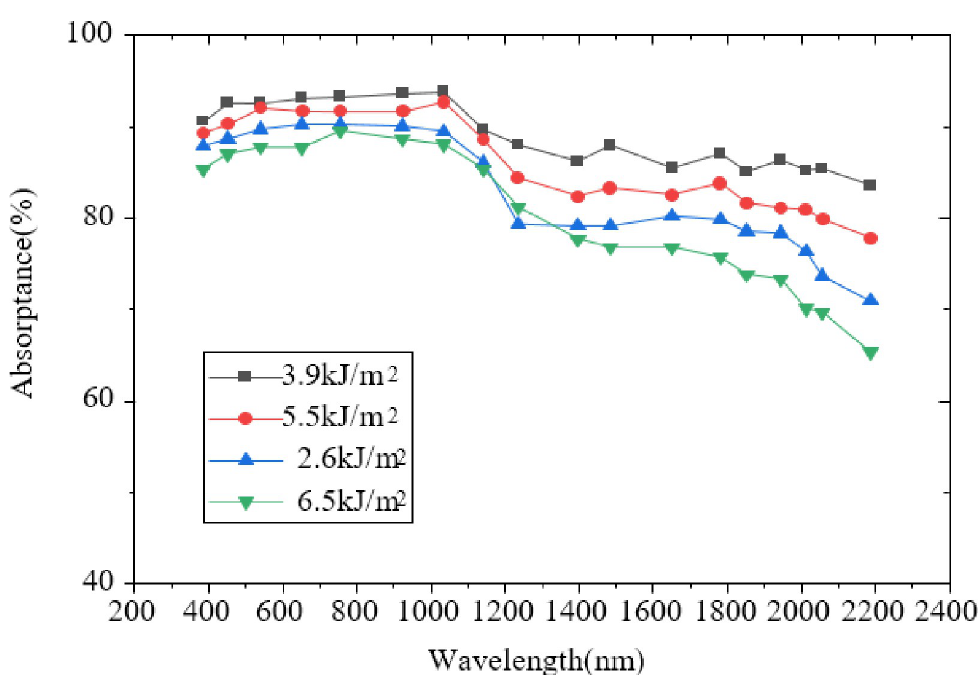
Fig 9. Comparison of absorption spectra of black silicon under different laser energy densities.